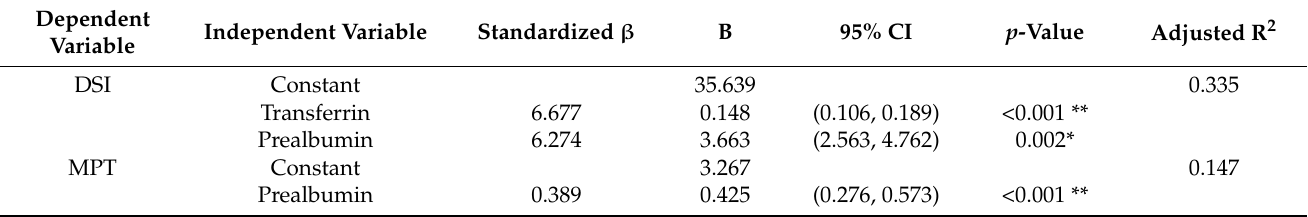
Table 6. Multiple linear regression analysis between nutritional markers, DSI, and